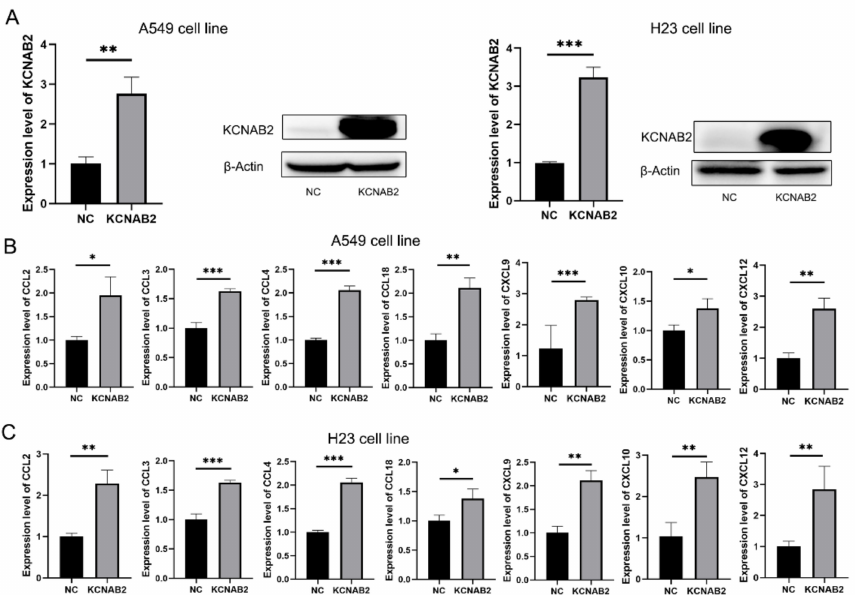
Figure 9. Real-time PCR results for analyzing the expression of tumor immune-related chemokines. ( A ) The overexpression effect of KCNAB2 in A549 cell line and H23 cell line was verified at the mRNA and protein levels. ( B , C ) Chemokines, including CCL2, CCL3, CCL4, CCL18, CXCL9, CXCL10, and CXCL12, were upregulated by KCNAB2 in A549 ( B ) and H23 cell lines ( C ). * p < 0.05, ** p < 0.01, *** p <